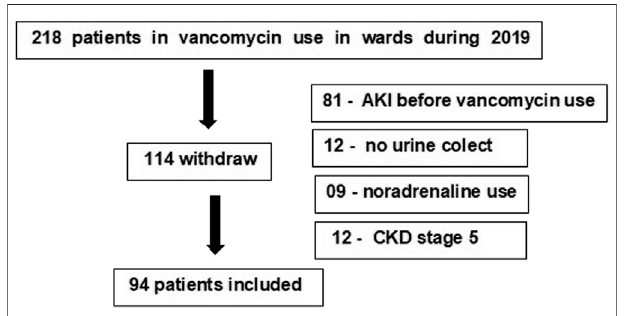
FIGURE 1 | Patients undergoing vancomycin and hospitalized in wards and included in the